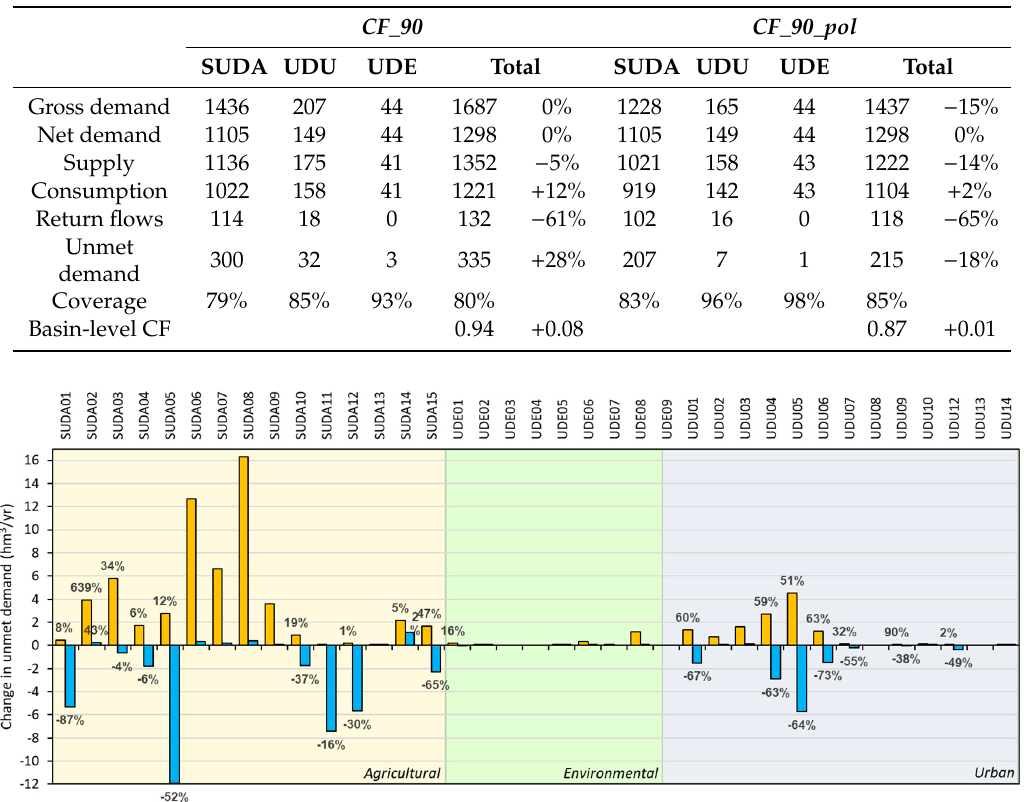
Table 4. Water demands, supply, and consumption simulated under the two scenarios. All values are in hm 3 / year. Percentages show changes of the basin-wide totals compared to the reference values, provided in Table 2. SUDA, UDU, and UDE refer to the totals for all agricultural, urban, and environmental demand sites, respectively.